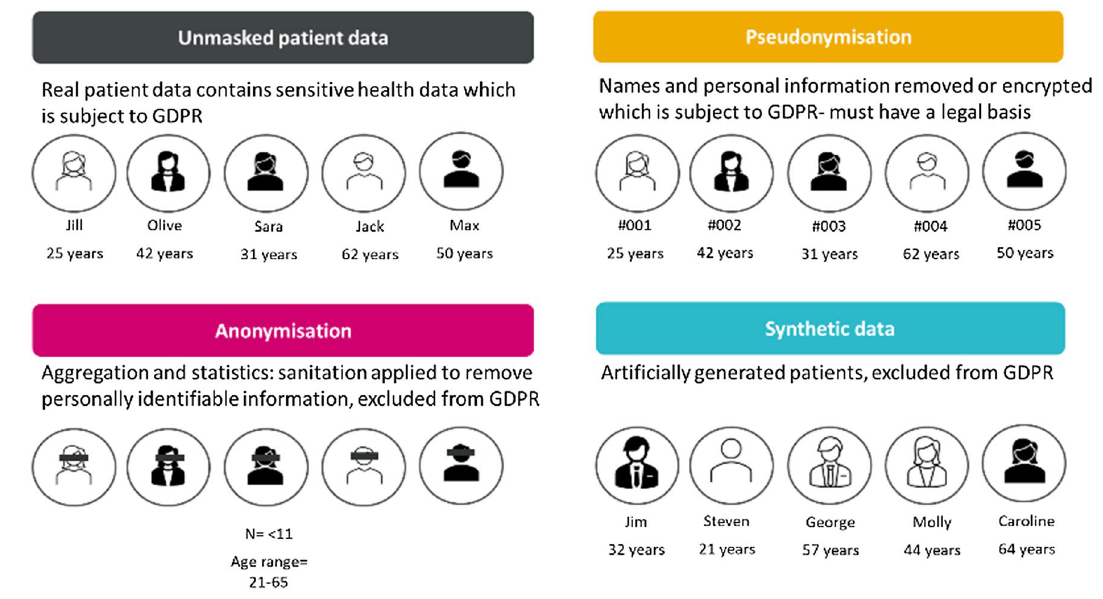
Fig. 4 The different privacy enhancing techniques that can be